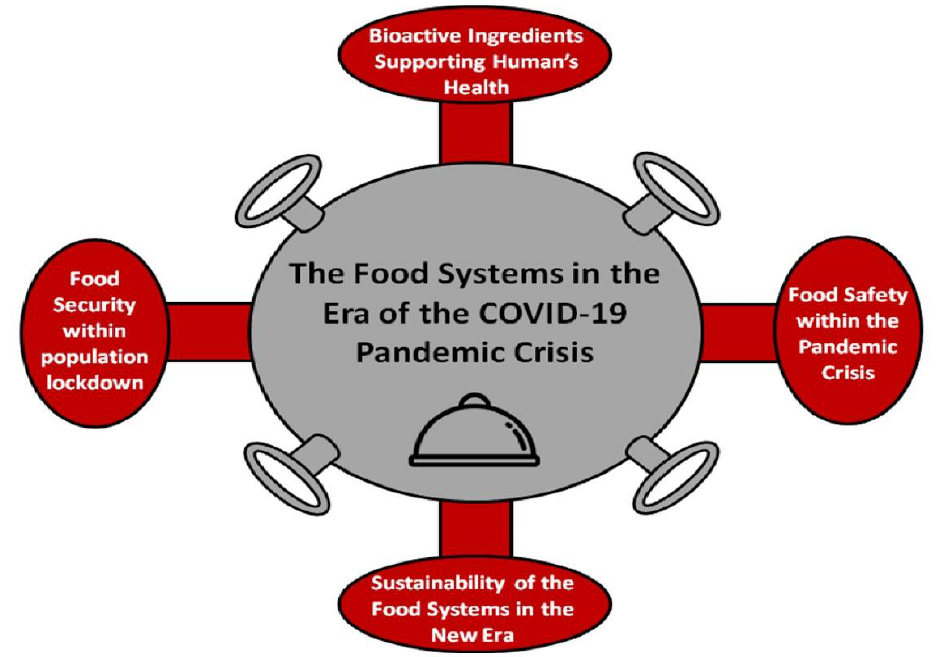
Figure 1. The food systems in the era of the coronavirus disease (COVID-19) pandemic crisis.